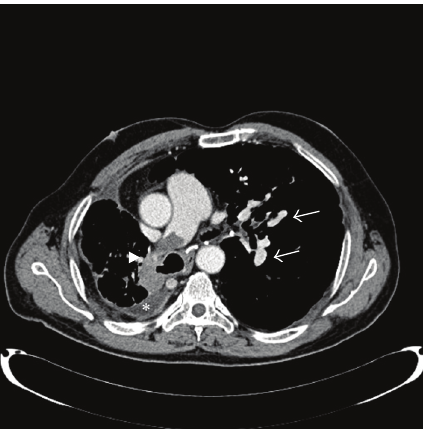
Figure 1: Computed tomography scan of the chest with contrast showing a pulmonary embolus in the right main pulmonary artery (arrow head), with calcified lymph nodes (arrow), in addition to right pleural effusion